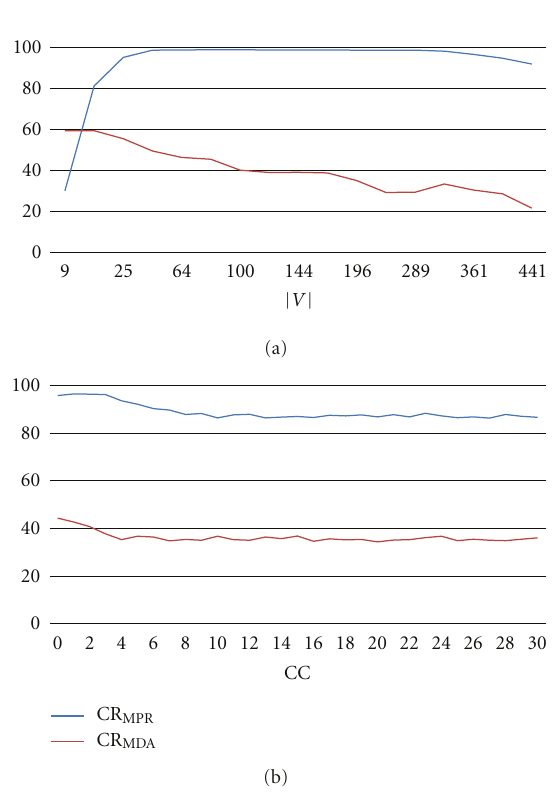
Figure 4: Comparing certificate rates.